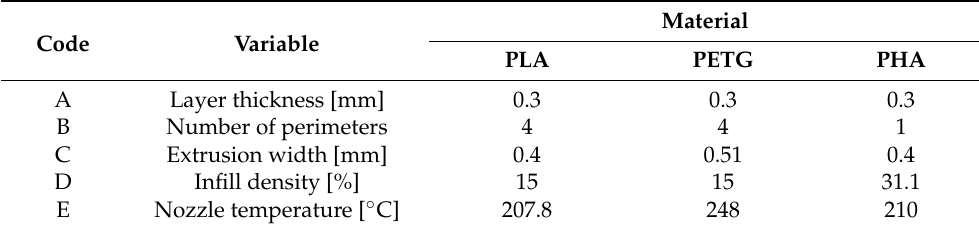
Table 6. Optimal values of 3D printer setup for PLA, PETG, and PEH according to all responses.